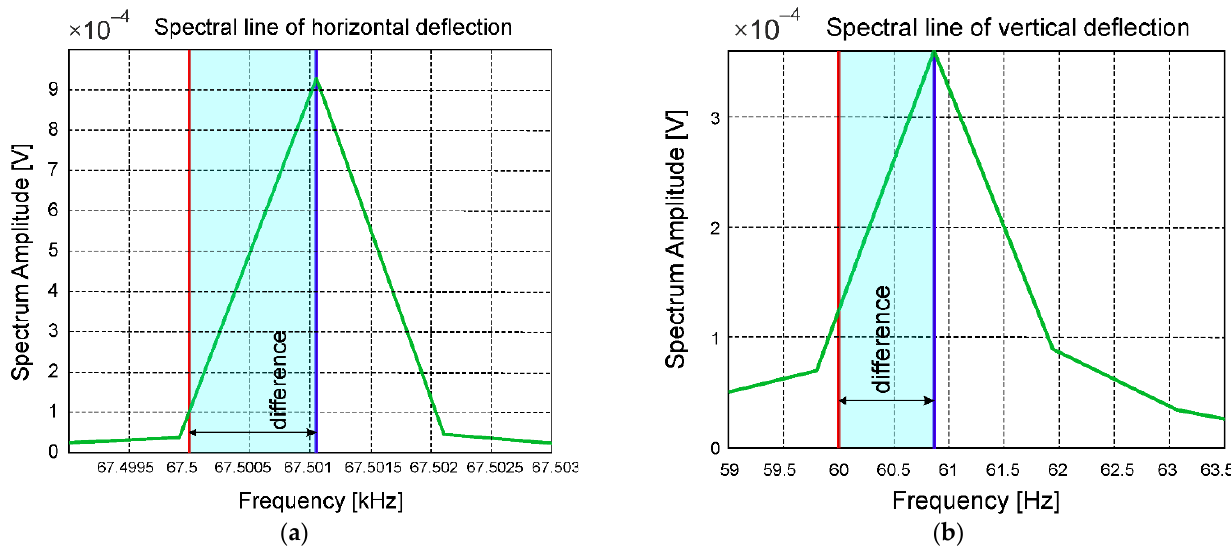
Figure 5. Magnification of the fragments of the amplitude spectrum corresponding to the ( a ) hori- zontal and ( b ) vertical sync frequencies. tal and ( b ) vertical sync